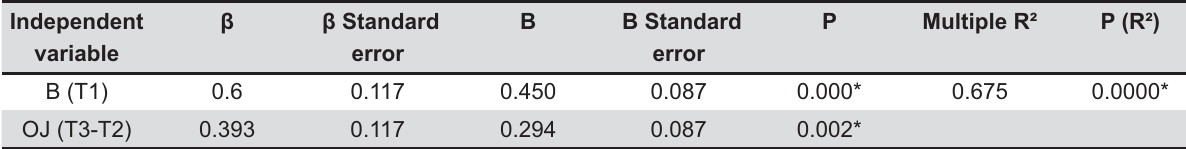
Table 4- Association of variables and midline maxillary diastema relapse (B T3-T2 - backward multiple linear regression analysis)